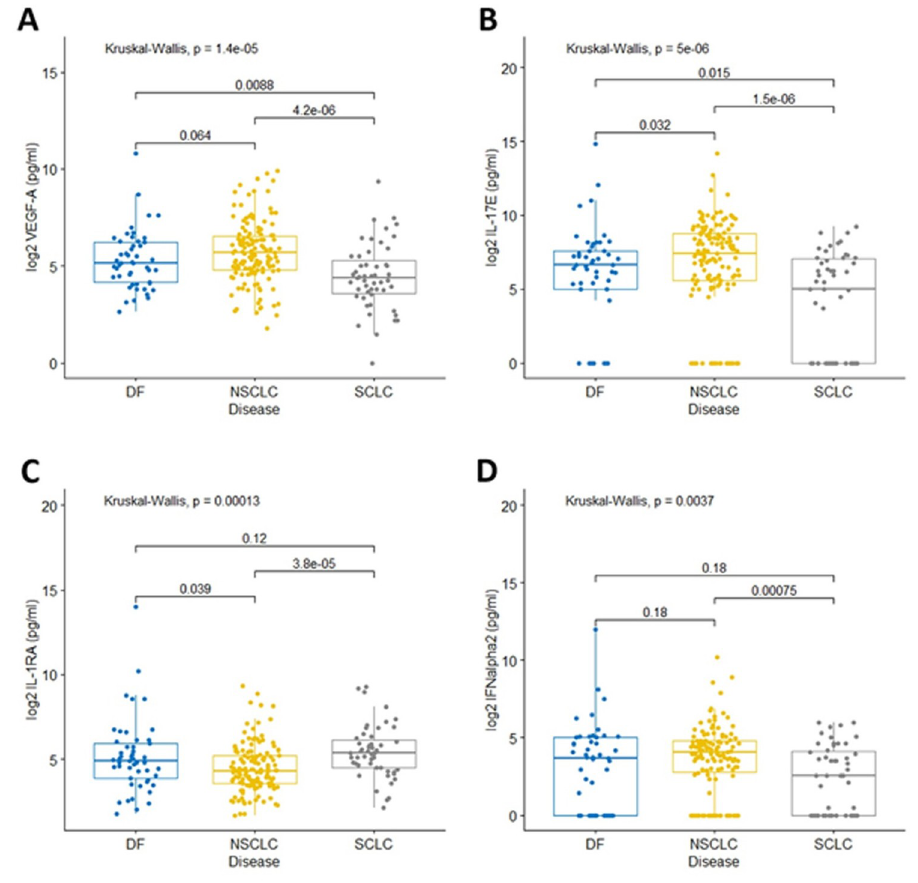
Fig 4. Comparing plasma factor abundances between lung cancer types. Plasma levels of factors that are significantly different between NSCLC and SCLC are plotted, VEGF-A (A), IL-17E (B), IL-1RA (C), and IFN α 2 (D). Resected patients with no evidence of disease (DF) are also plotted for comparison. Kruskal-Wallis p-values are displayed at the top of each plot and pair-wise comparisons using a Dunn test are shown.